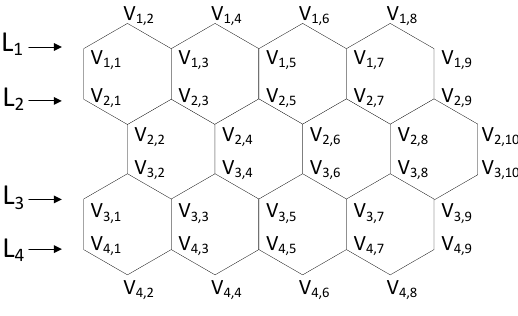
Figure 1. Horizontal zigzag lines denoted by L i , i = 1, . . . 4, and vertices of H 4,3 . Grid H 4,3 has m = 4 hexagons in a row and n = 3 hexagons in a column. As an example, L 1 consists of vertices v 1,1 , v 1,2 , v 1,3 , v 1,4 , v 1,5 , v 1,6 , v 1,7 , v 1,8 , v 1,9 . Similarly, L 2 consists of vertices v 2,1 , v 2,2 , v 2,3 , v 2,4 , v 2,5 , v 2,6 , v 2,7 , v 2,8 , v 2,9 , v 2,10